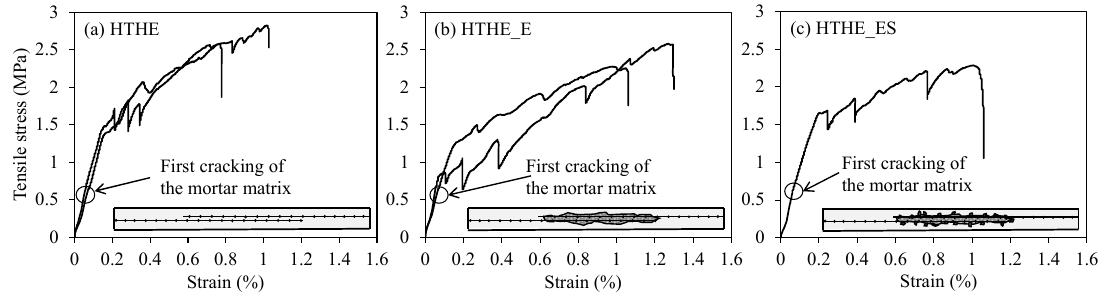
Figure 15. Tensile stress–strain relationship of TRM coupons with different surface treatments in the high temperature and humidity environment: ( a ) coupons without surface treatment; ( b ) coupons impregnated by epoxy; ( c ) coupons coated with aluminum oxide powder after epoxy impregnation. Appl. Sci. 2019 , 9 , x FOR PEER REVIEW